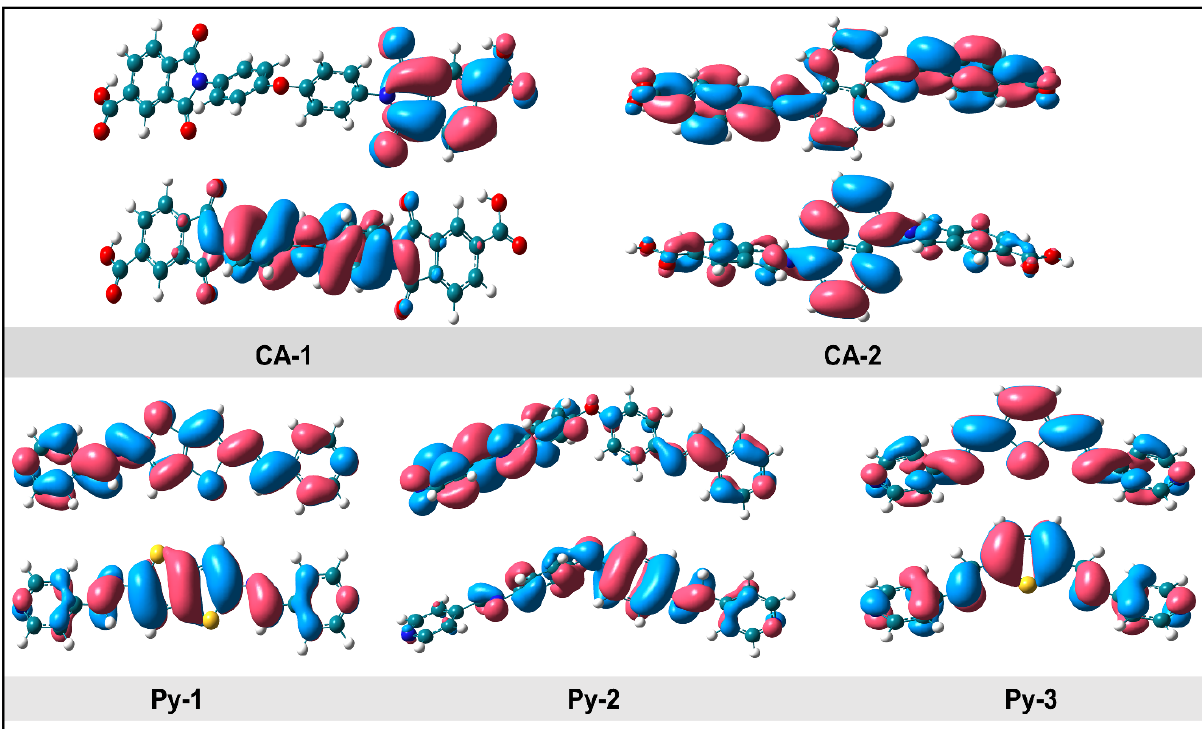
Figure 4. Contour plots of the HOMO and LUMO of isolated dyes. In all the cases the isovalue is set to 0.02. HOMO level is depicted below and LUMO level is depicted above for each dye design.